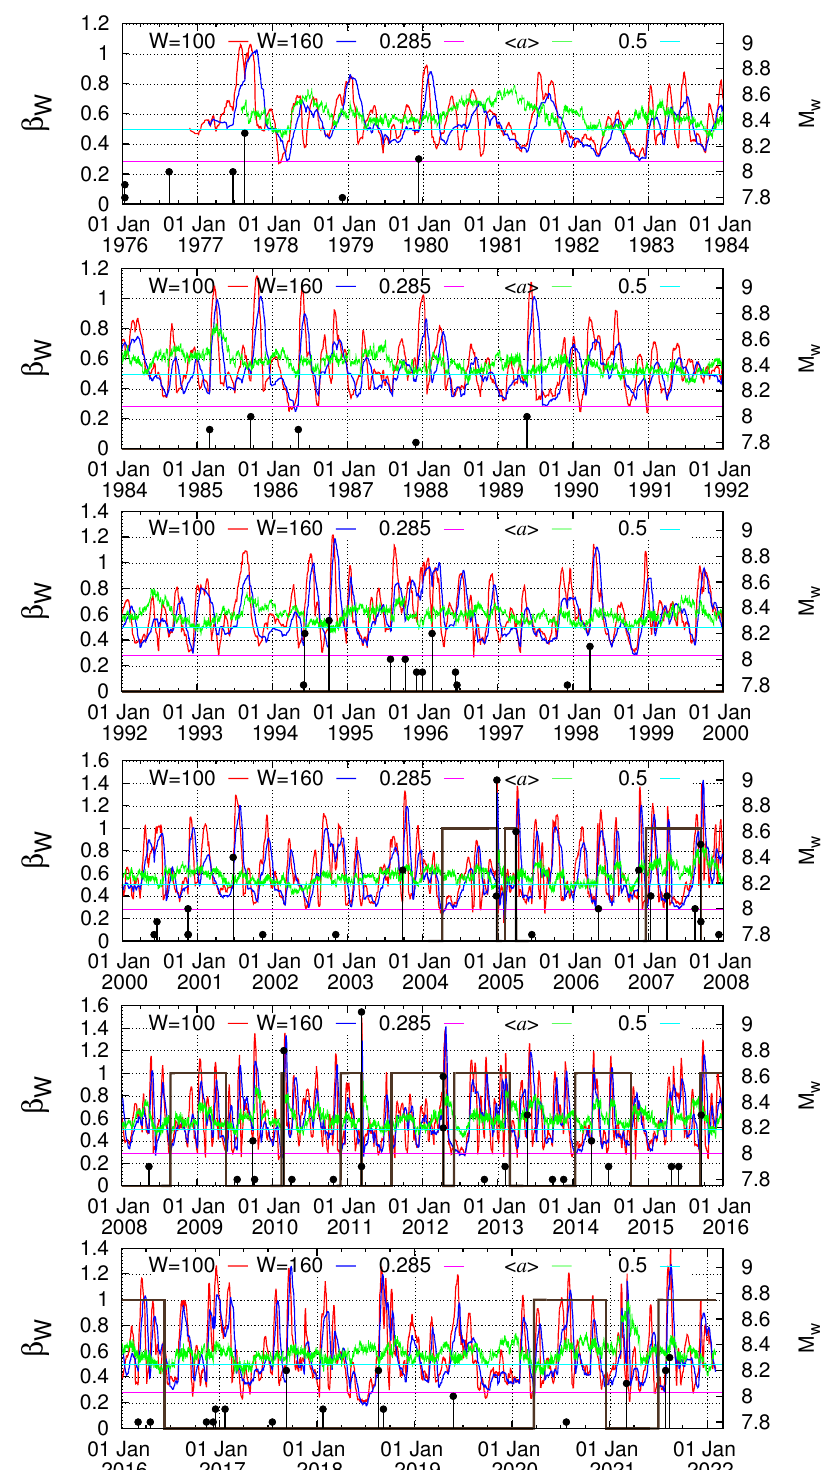
Figure 4. The order parameter fluctuations for global seismicity as depicted by the variabilities β W for W = 100 (red) and W = 160 (blue) during the period from 1 January 1976 to 31 January 2022. The EQ magnitudes, which are read in the right scale, are denoted by the (black) vertical lines ending at solid circles. The horizontal magenta and cyan lines correspond to the values 0.285 (= β 0 ) and 0.5, respectively. The thick dark brown line resembling a dichotomous (ON/OFF) signal, indicates when an alarm is ON by taking the value 1. Otherwise, there is no alarm. The average DFA exponent (cid:104) α (cid:105) discussed in Section 4 is also shown by the green